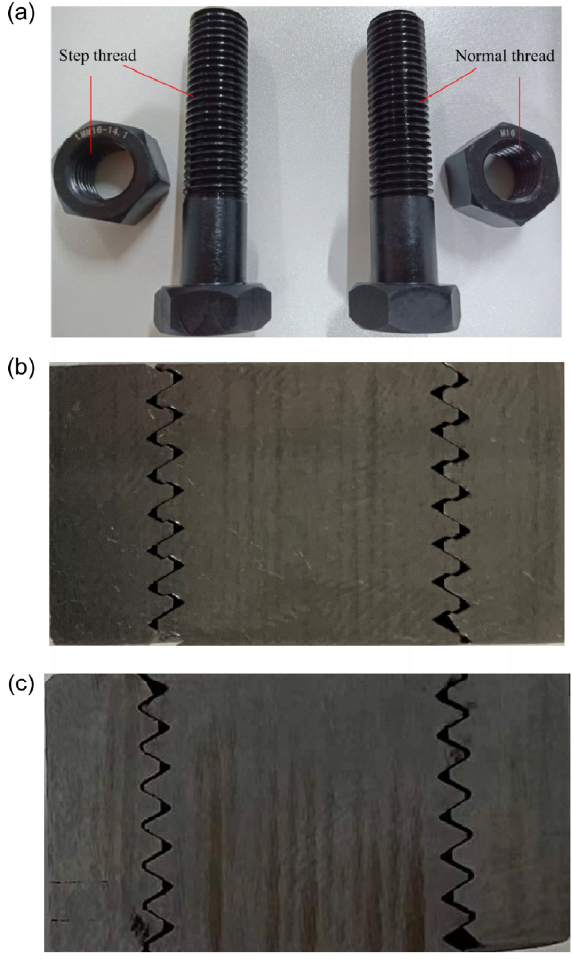
Fig. 19 Manufactured novel and regular bolted joints, and section profiles of the engagement threads: (a) novel and regular bolted joint; (b) section profile of step external and internal threads; (c) section profile of the normal external and internal threads.